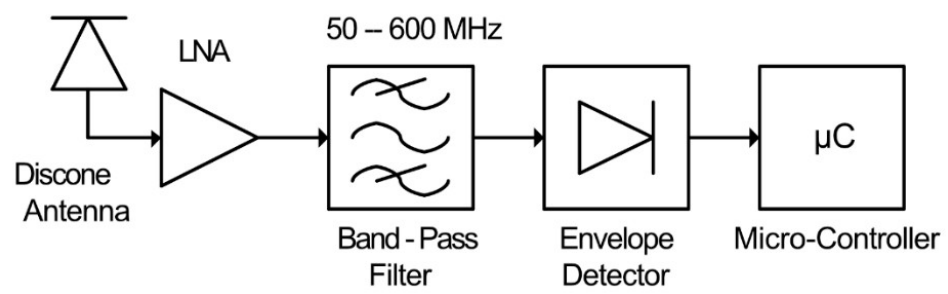
Figure 7. Single channel PD sensor proposed in [56].